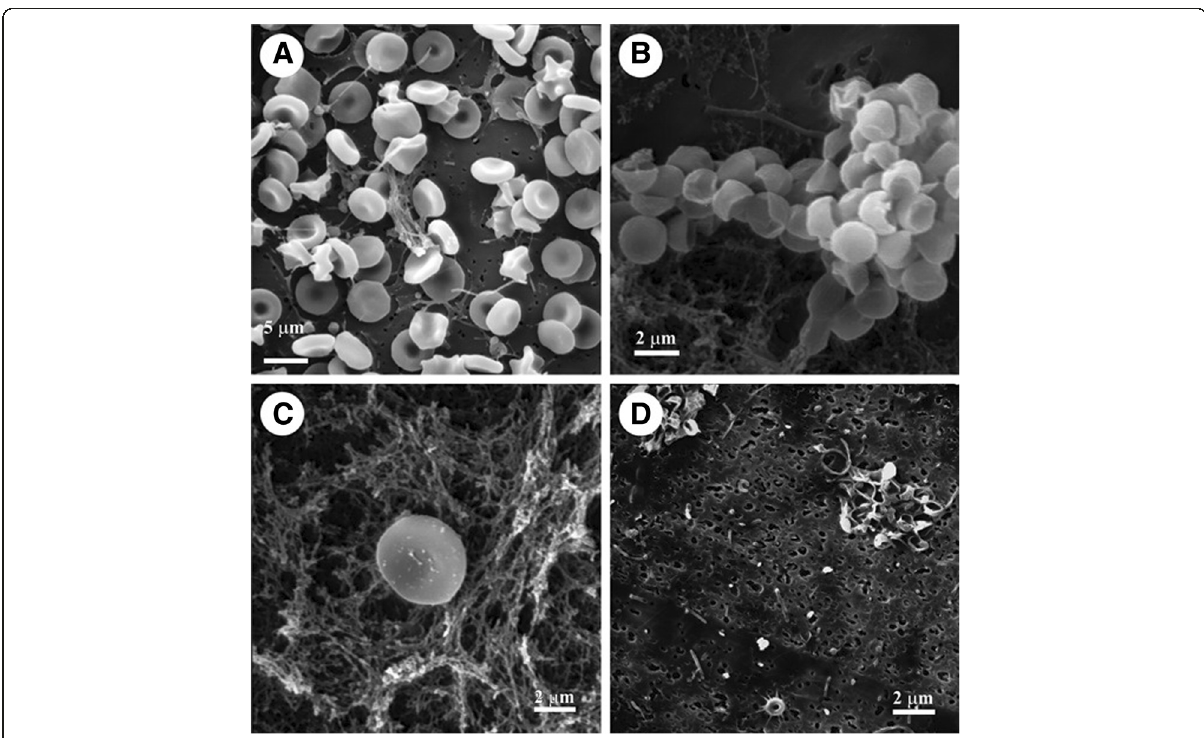
Fig. 6 a Control erythrocytes preincubated with Alsever ’ s solution. b and c Erythrocytes preincubated with an HU 50 of the M. alcicornis aqueous extract, note the amorphous material from the broken-down membranes in the background. d Remains of the erythrocytes membranes completely destroyed after incubation in the presence of 10-fold the HU 50 of the M. alcicornis aqueous